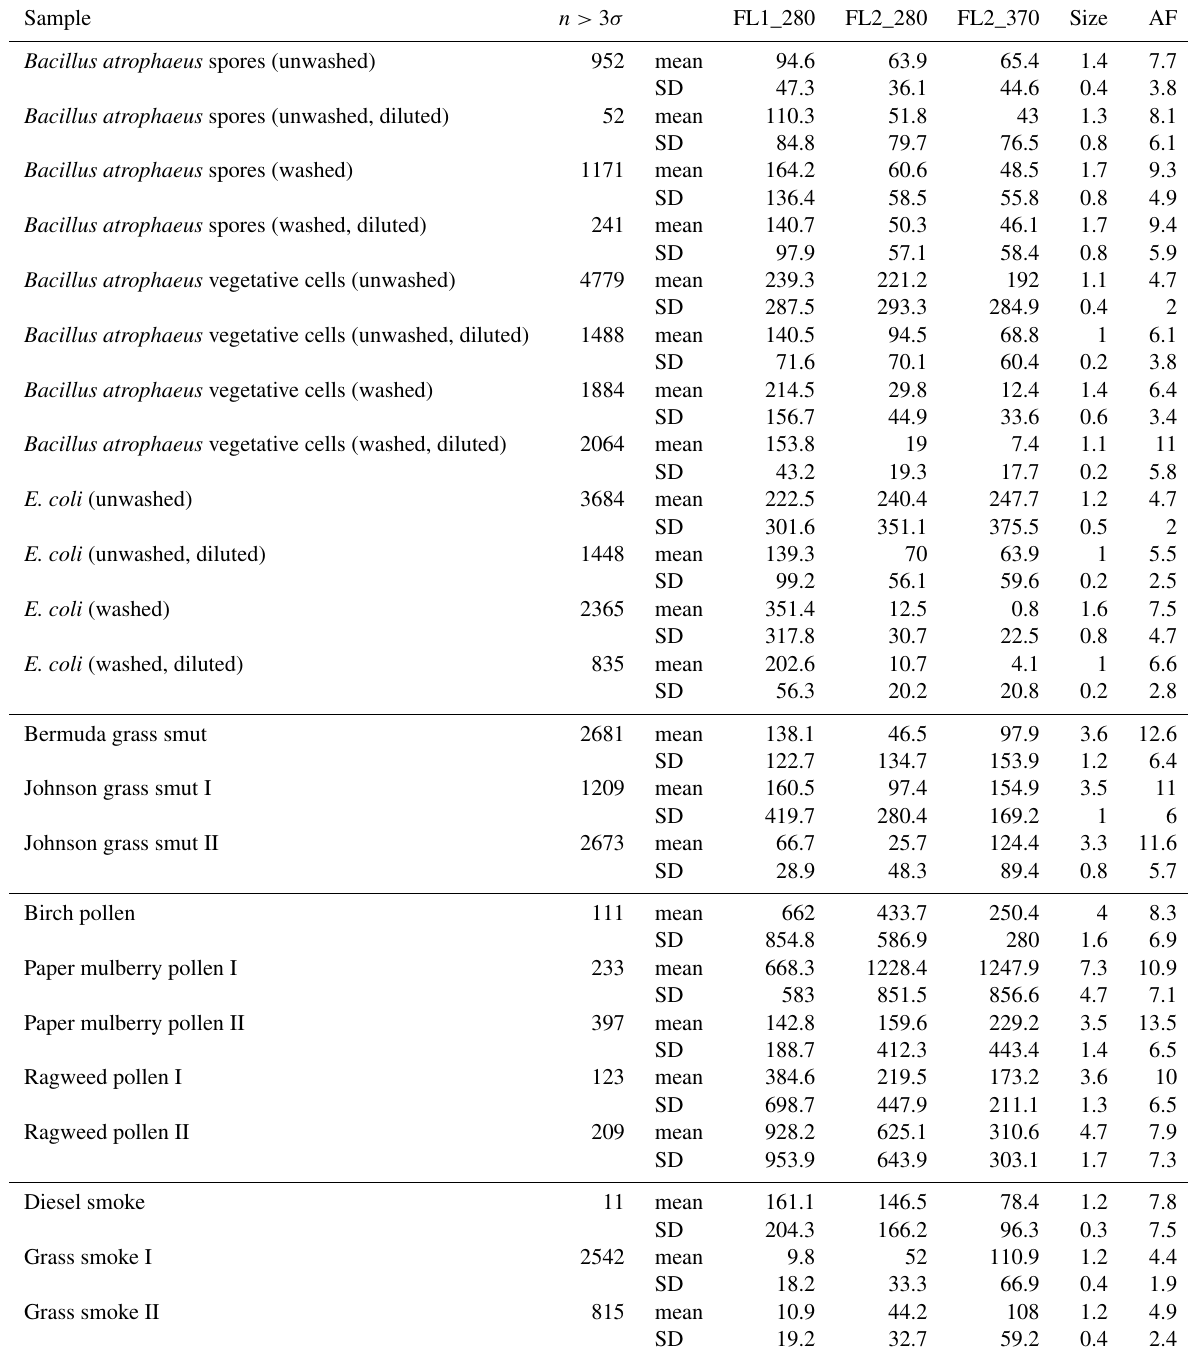
Table C1. Summary of particle measurements for the 2008 data set using a fluorescent threshold of 3 σ .